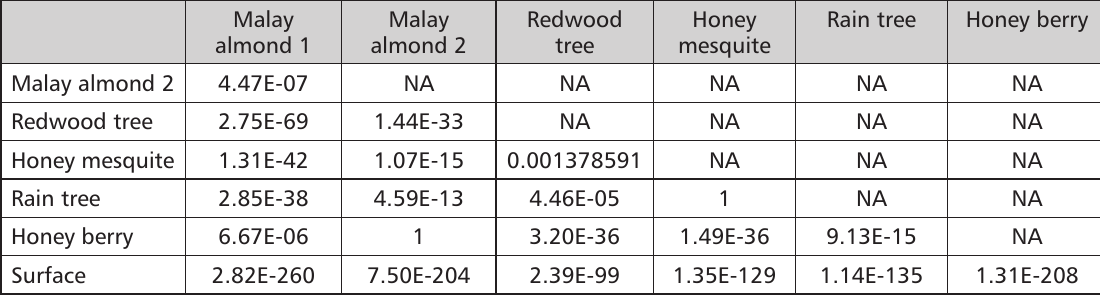
Redwood Honey Rain tree Honey berry tree